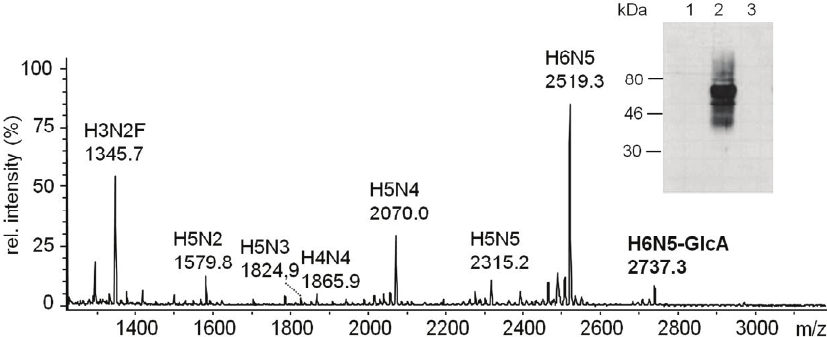
Figure 6. Analysis of the non-sulfated HNK1-antigen produced by in vitro glucuronylation of asialofetuin with dGlcAT-P sol. The MALDI-MS spectrum of the permethylated N -glycans shows a mono-glucuronylated sugar at m / z 2737. This was immunochemically verified by applying GlcA-fetuin (3 μg/lane) on a Western blot using the anti-HNK1 antibody M6749 (insert). The signal disappears after PNGaseF and β -glucuronidase digestion, verifying β 1-3 linked GlcA on N -glycans. 1: GlcA-modified fetuin + PNGaseF; 2: GlcA-modified fetuin; 3: GlcA-modified fetuin + β -glucuronidase. Short notation of glycan structures: H, hexose; N, N -acetylhexosamine; F, fucose; GlcA, glucuronic acid.